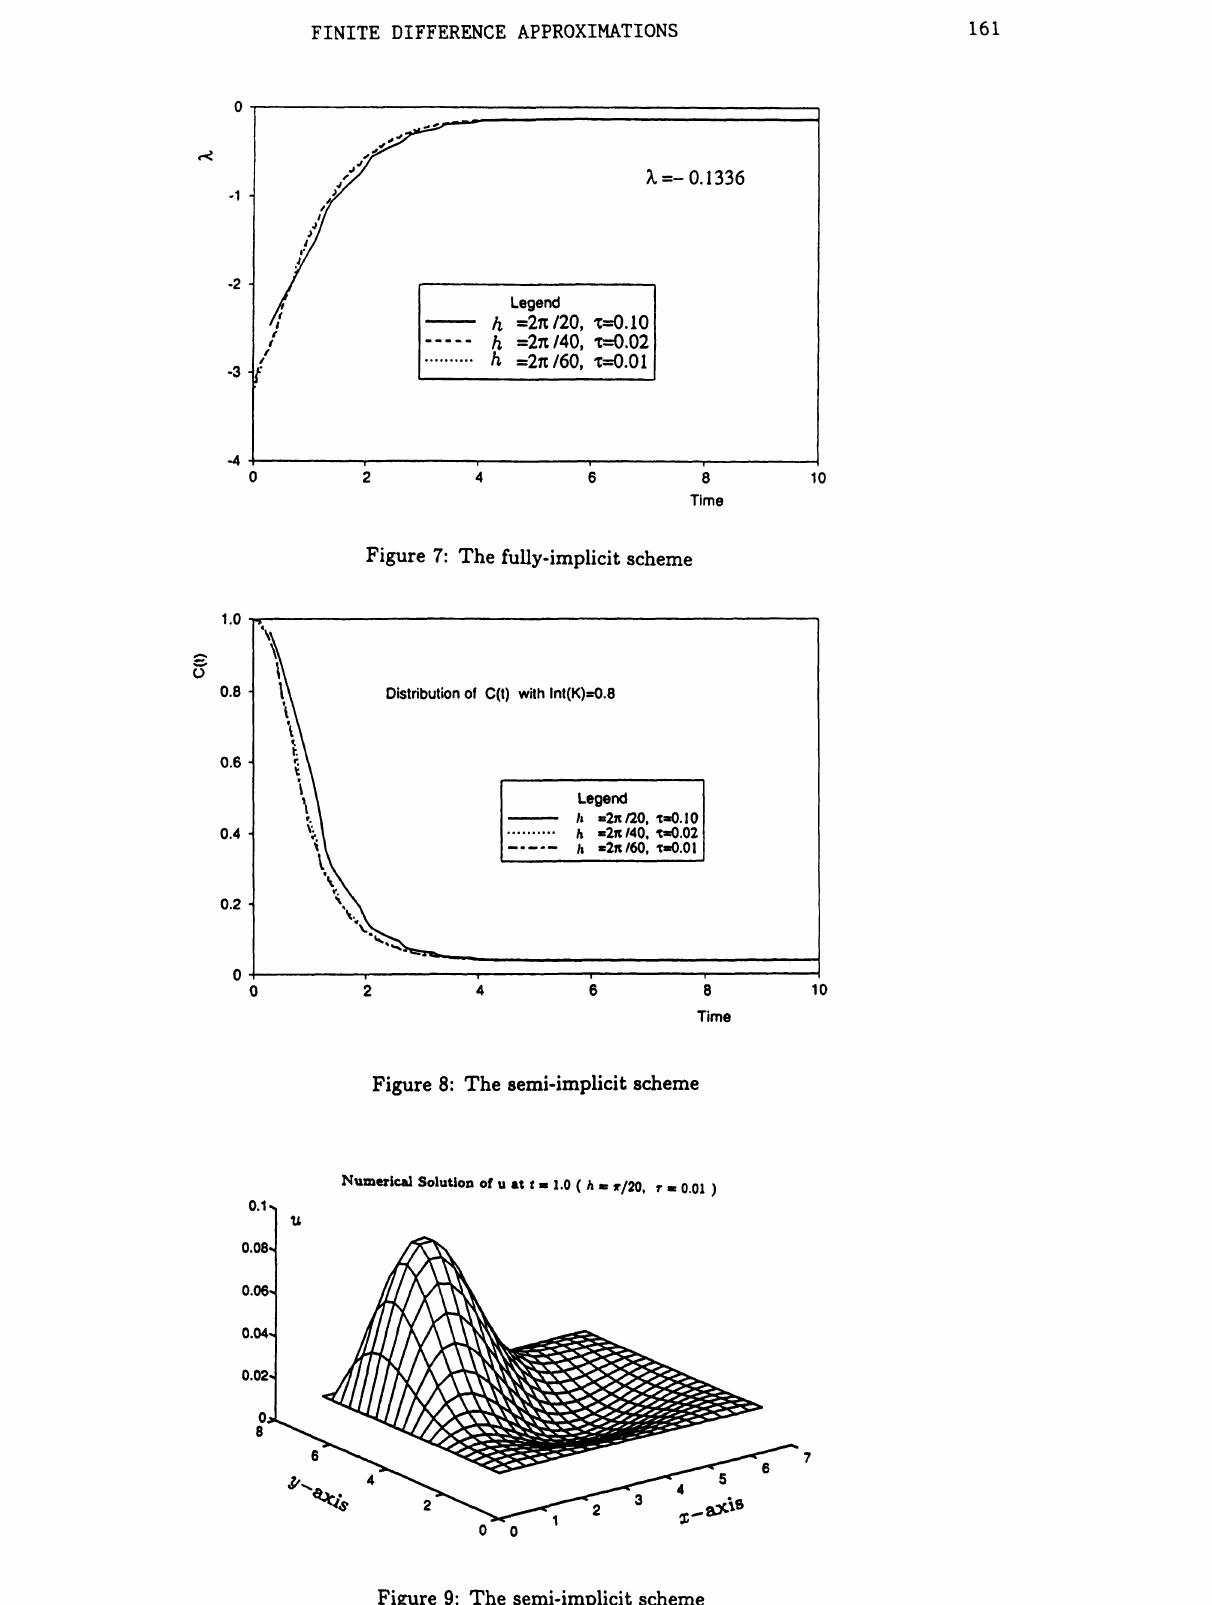
Figure 9: The semi-implicit